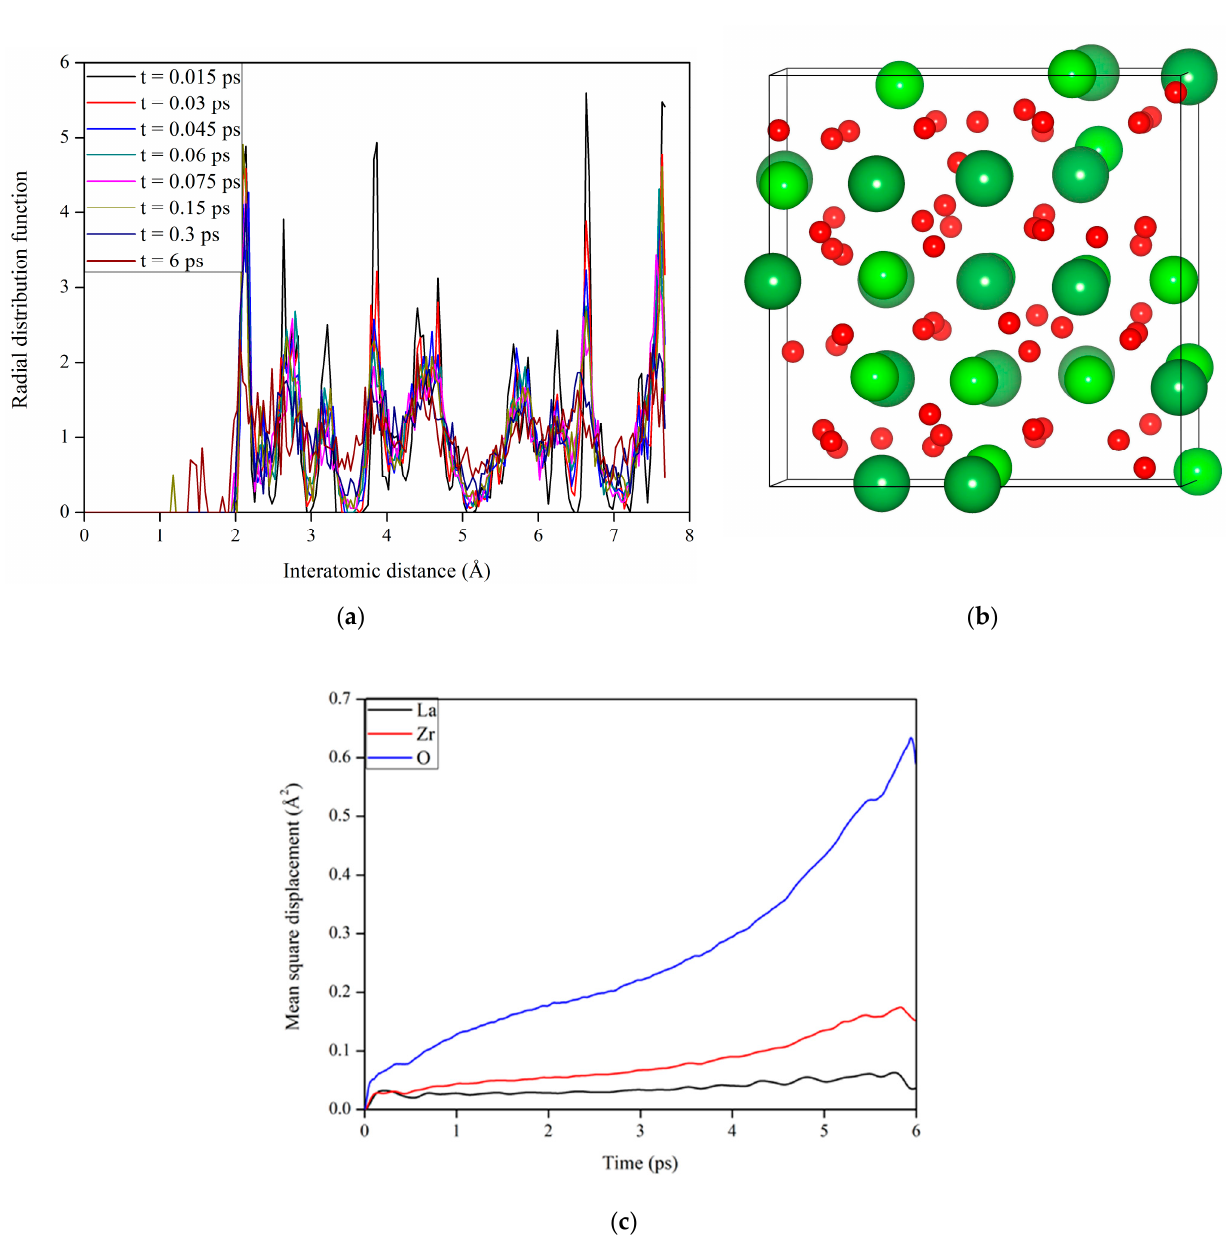
Figure 4. ( a ) Variation of radial distribution function (RDF) with time, ( b ) schematic view of the geometrical structure, and ( c ) variation of mean square displacement (MSD) with time for La 2 Zr 2 O 7 with 1.6% electron excitation.